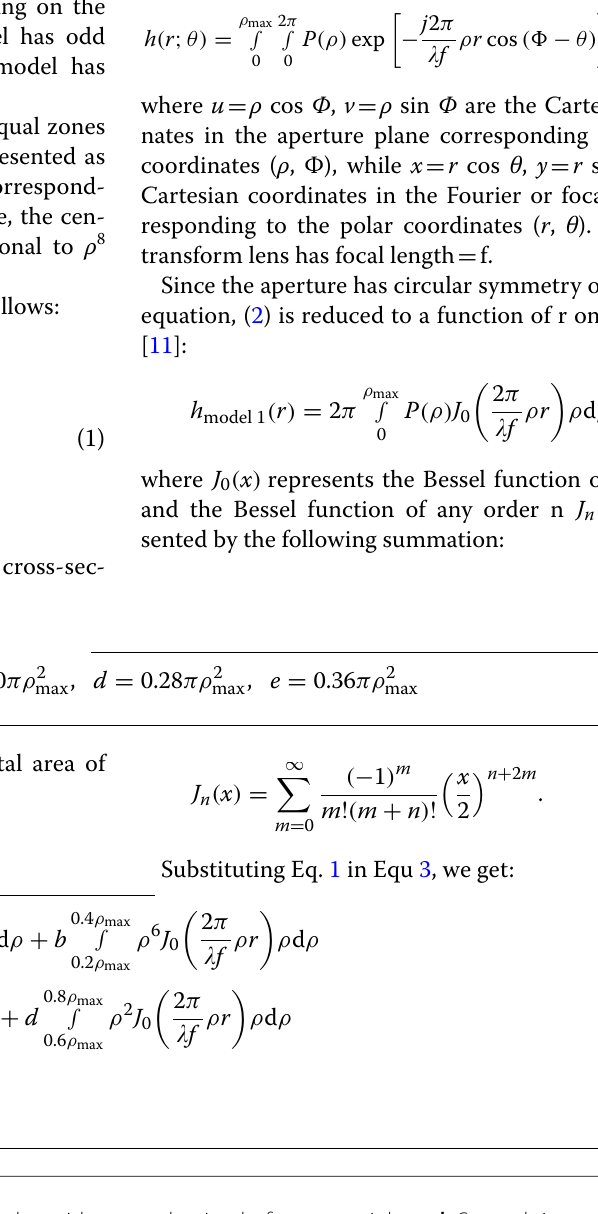
512 pixels and the total radius of the aperture 128 pixels. c The intensity plot of the × =